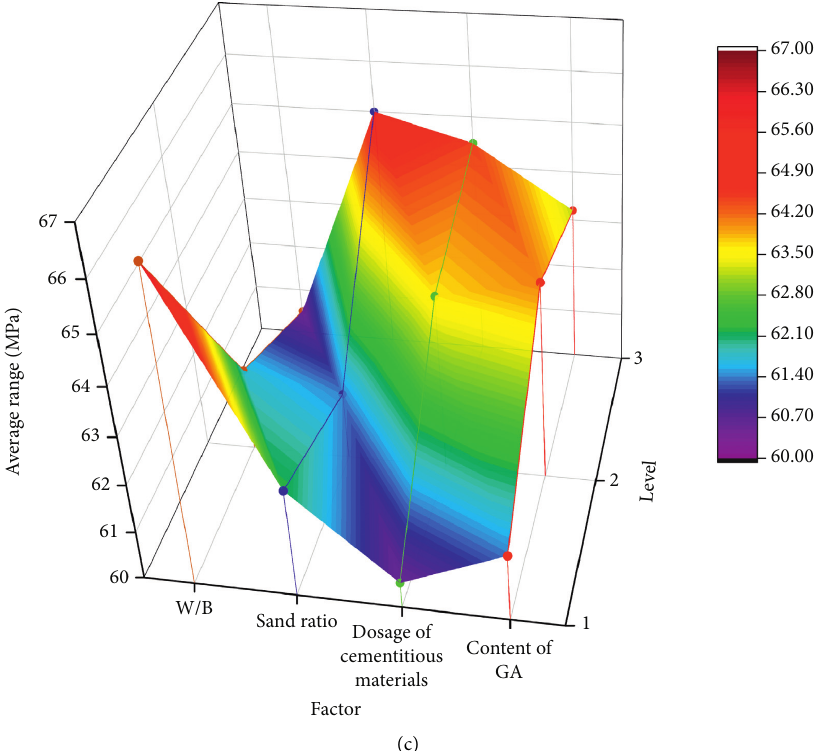
Figure 18: Diagram of mixing amount of water reducer and compressive strength of GAC. (a) The dosage of water reducing agent range; (b) compressive strength at 7 days; (c) compressive strength at 28d.